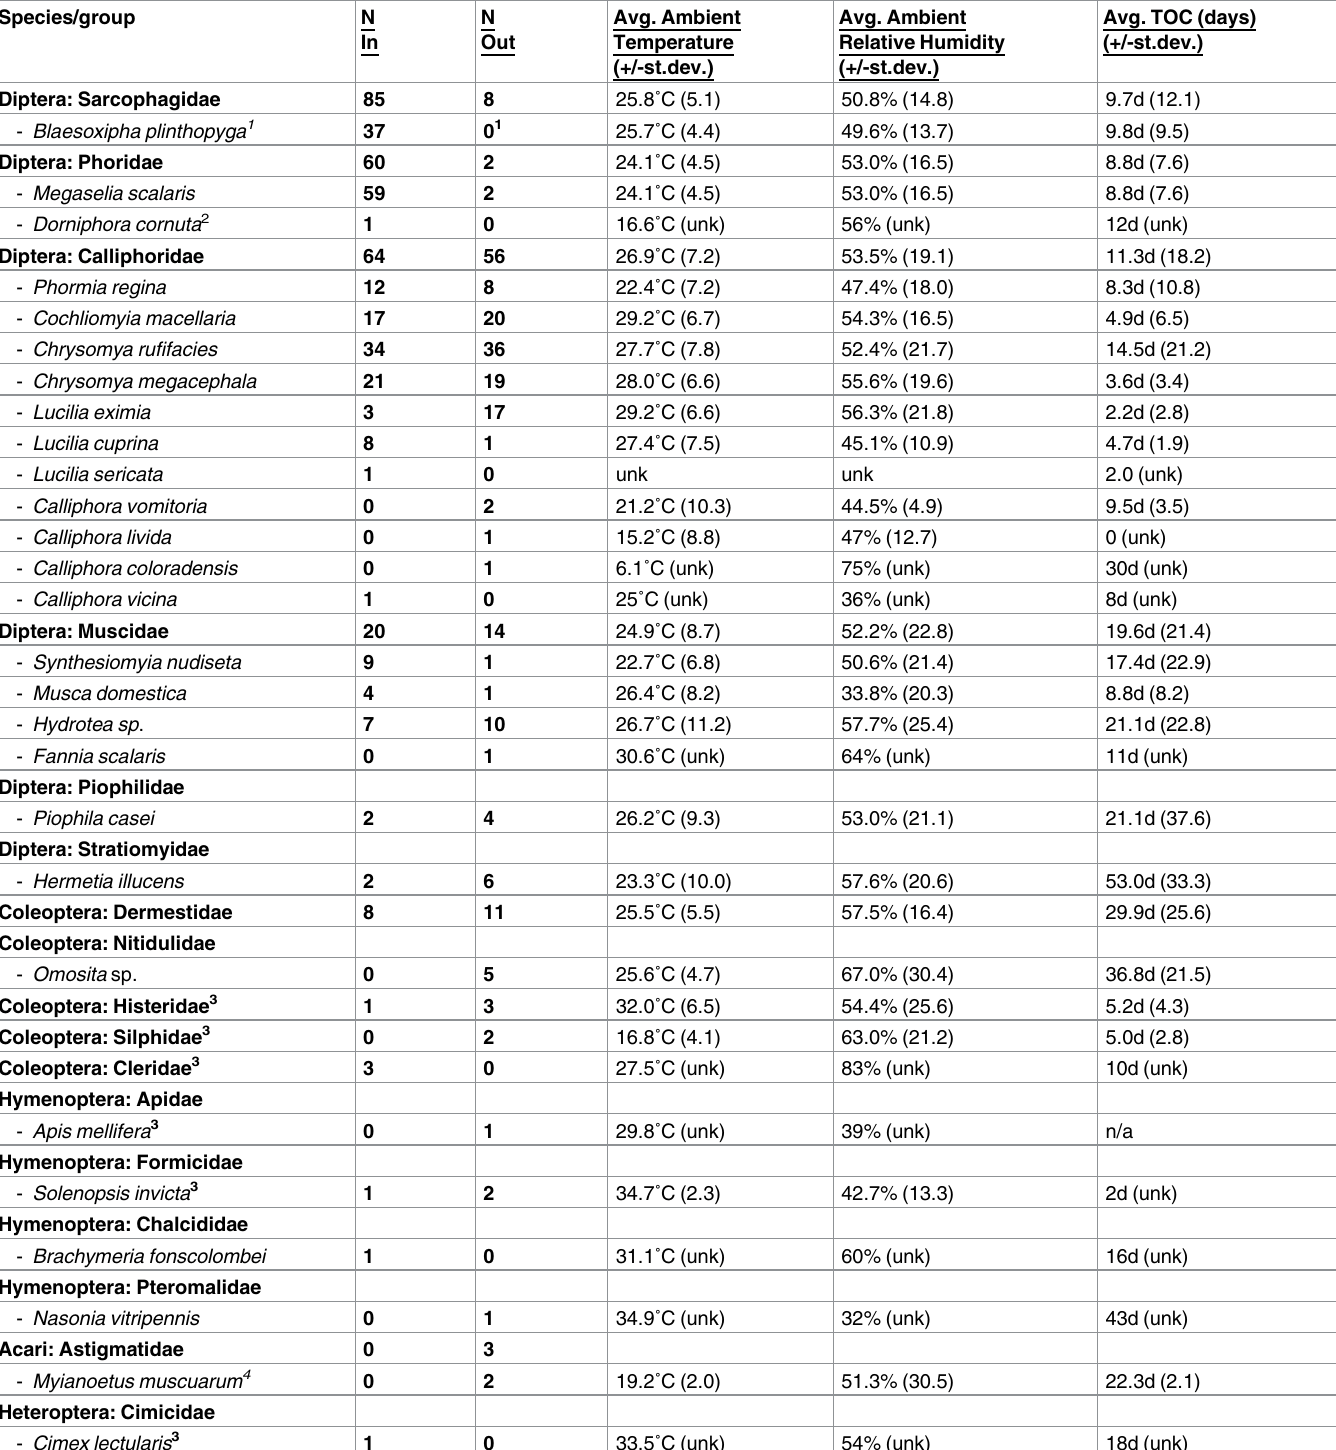
Table 1. Averageenvironmental factors by collected species.